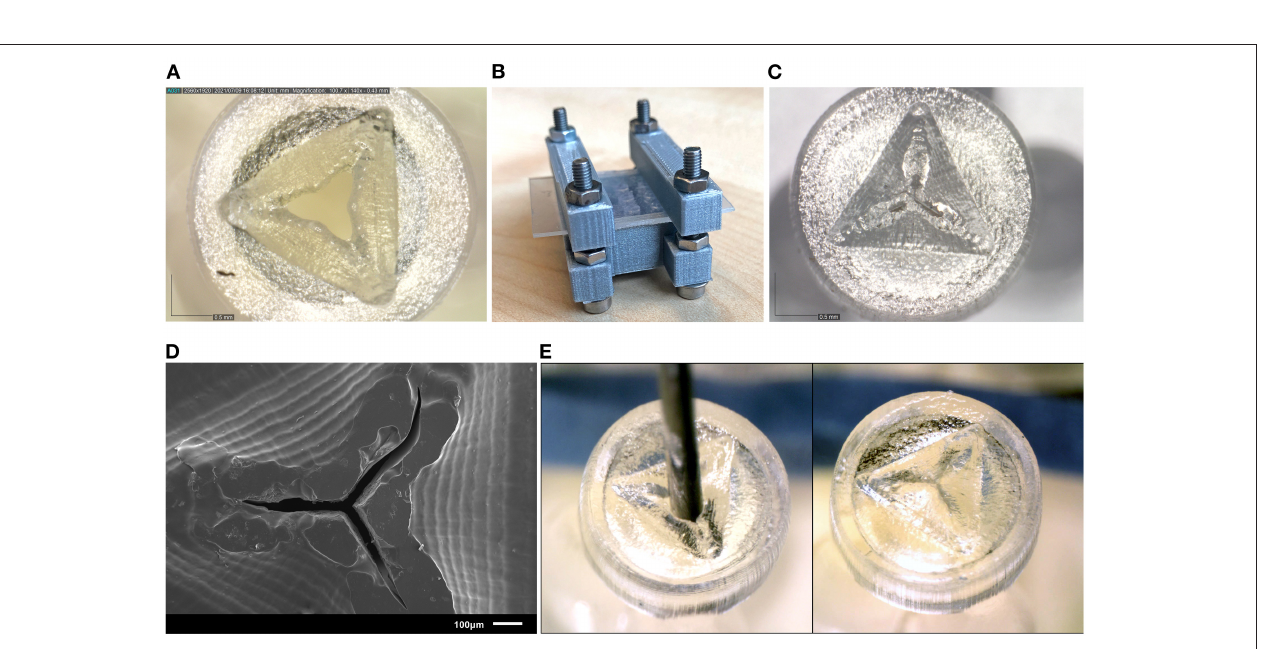
Frontiers in Medical Technology |